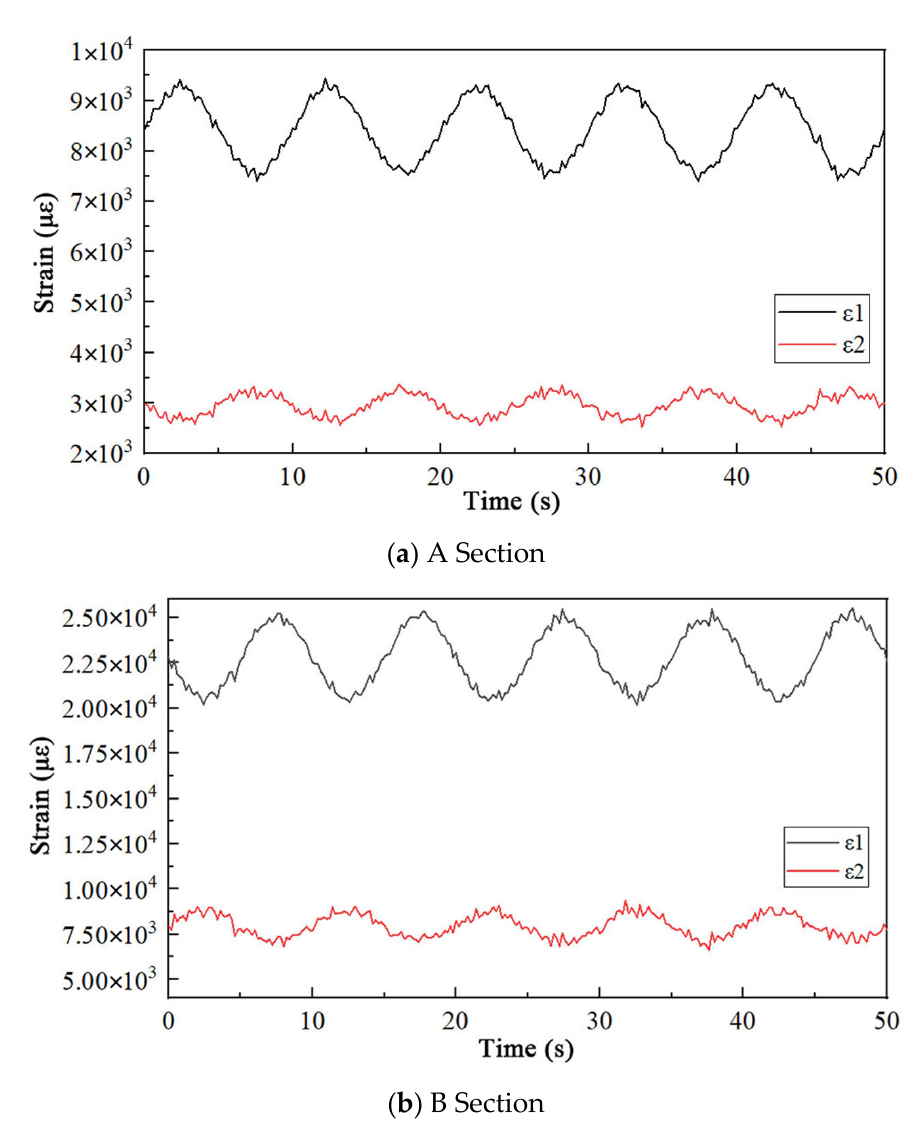
Figure 19. Strain Curve of the Lifting Arm Under 5th-Grade (Rough) Sea State: ( a ) at A Section and ( b ) at B Section.